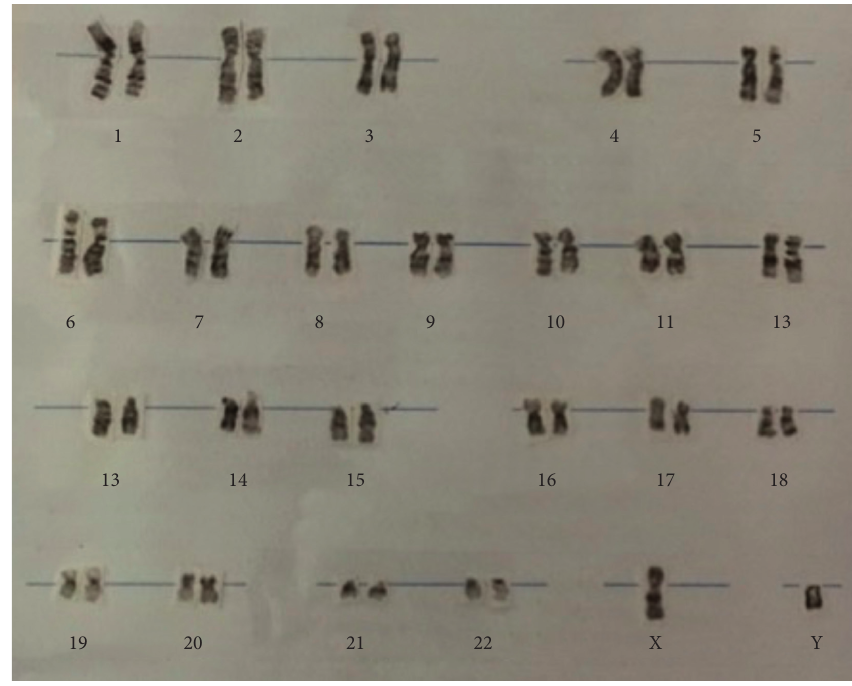
Figure 2: Normal male karyotype 46, XY.